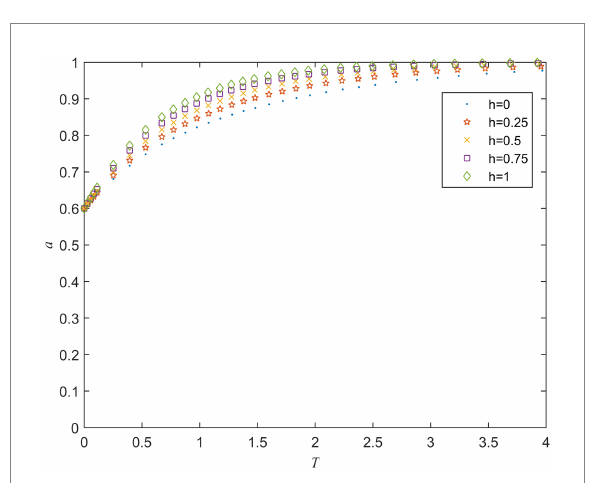
FIGURE 7 Strategy evolution of the public sector under different values of h